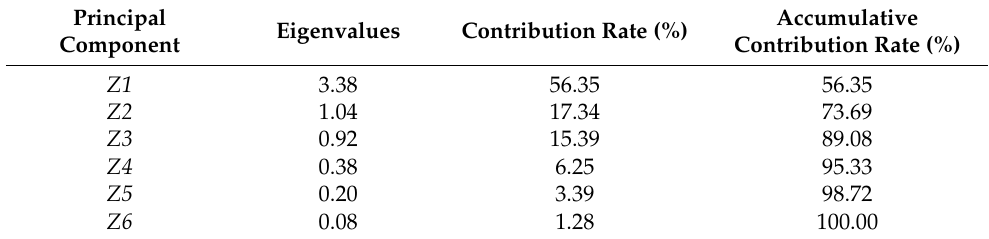
Table 4. Principal component load.